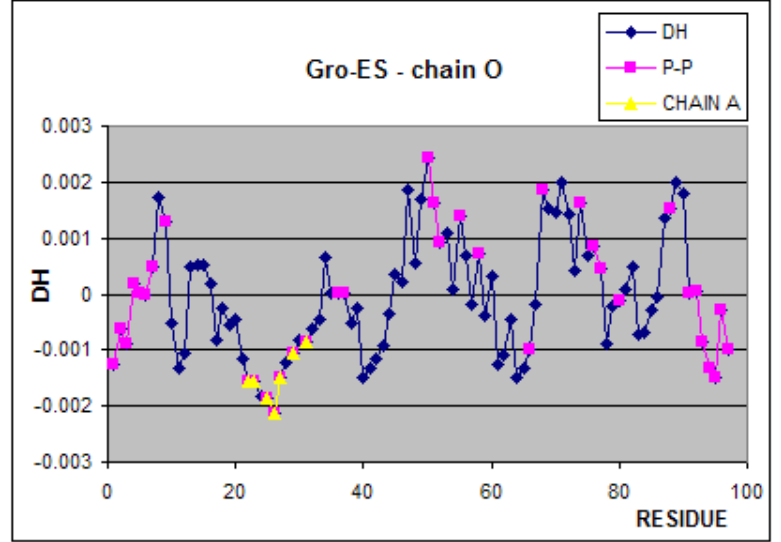
~ Figure 6. The H Δ profile for chain O as calculated for the entire Gro-ES fragment. The pink positions distinguish the residues engaged in protein-protein interaction, the yellow positions show the residues engaged in the interaction with the chain A of cis ring in the Gro-EL